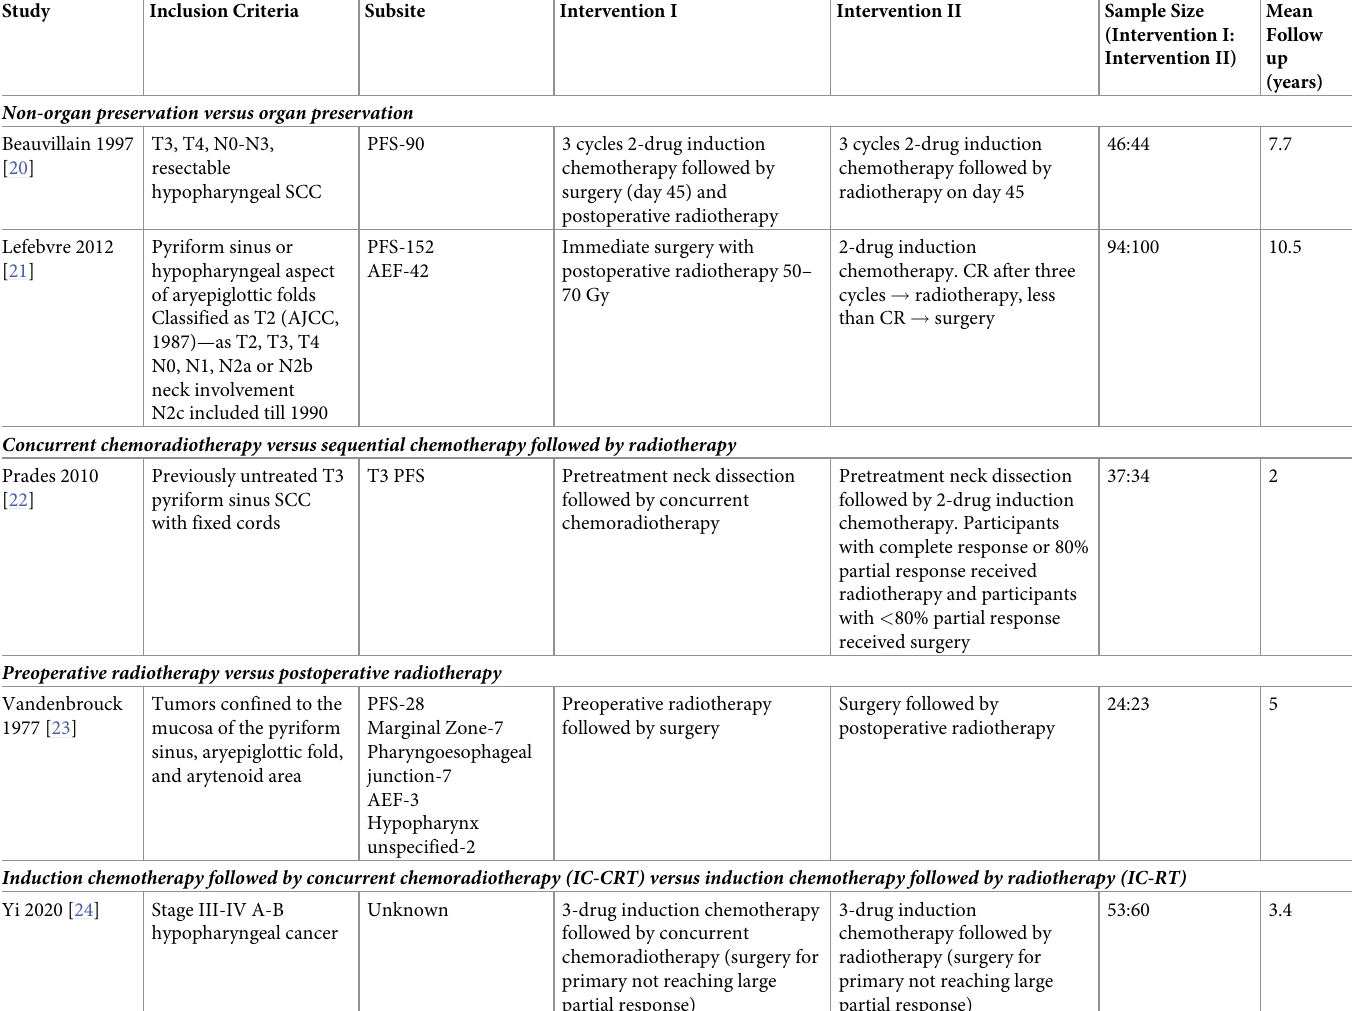
Table 1. Characteristics of included